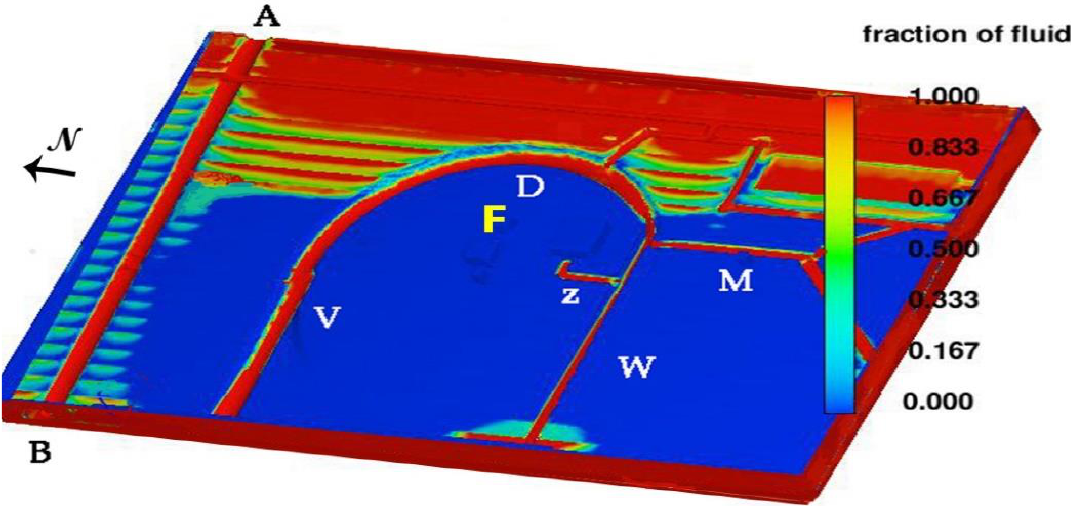
Figure 50. Dry season continuance with additional ground surface evaporation drying and aquifer drainage; from [2], p. 179. A,B represents the Tiwanaku River.